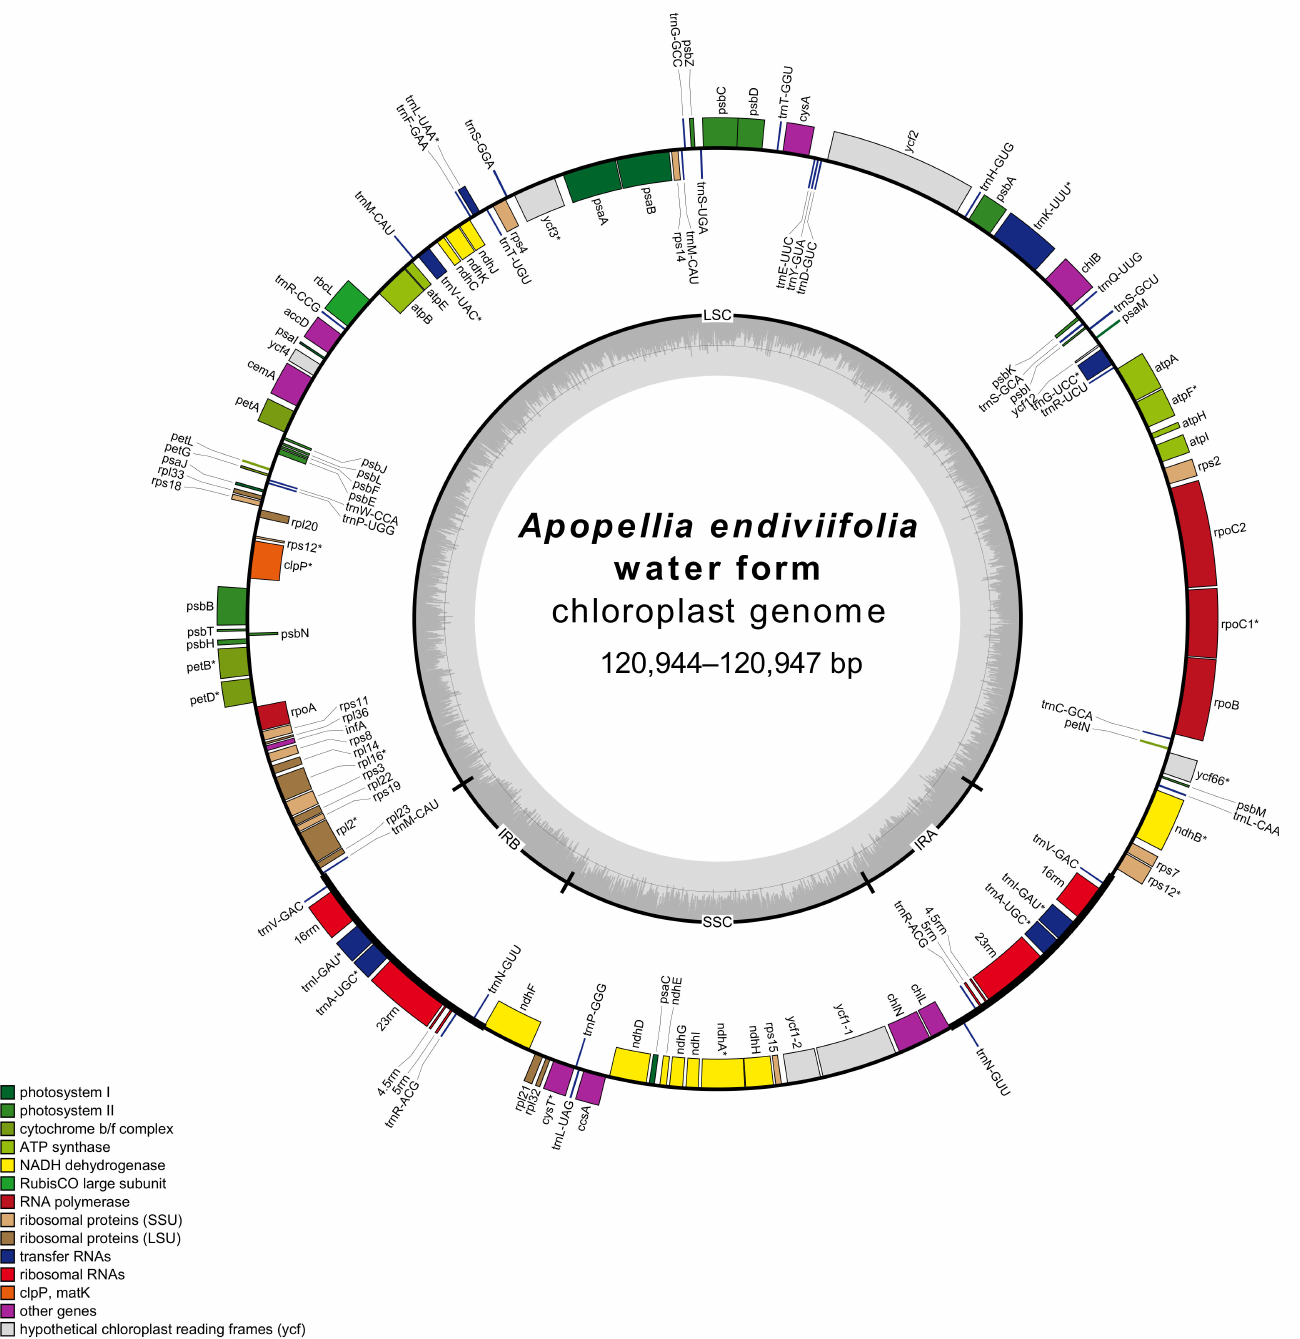
Figure 1. Gene map of the chloroplast genome of Apopellia endiviifolia water form. Genes inside and outside the outer circle are transcribed in counterclockwise and clockwise direction, respectively. The genes are color-coded based on their function. The inner circle visualizes the GC content. * indicate genes containing